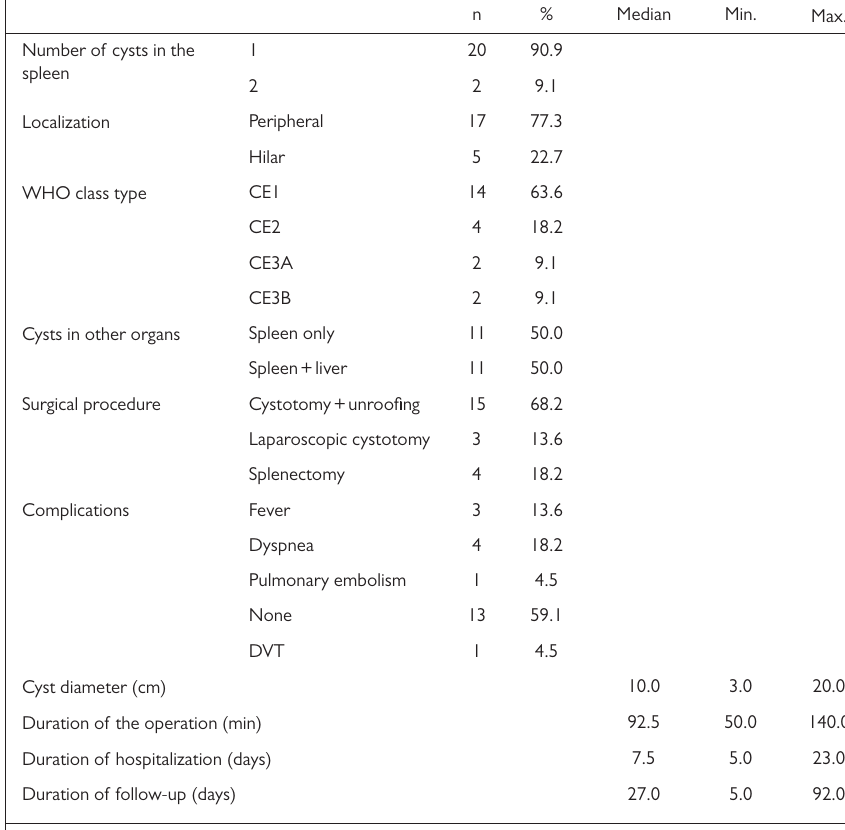
Table 1. Descriptive Findings of the